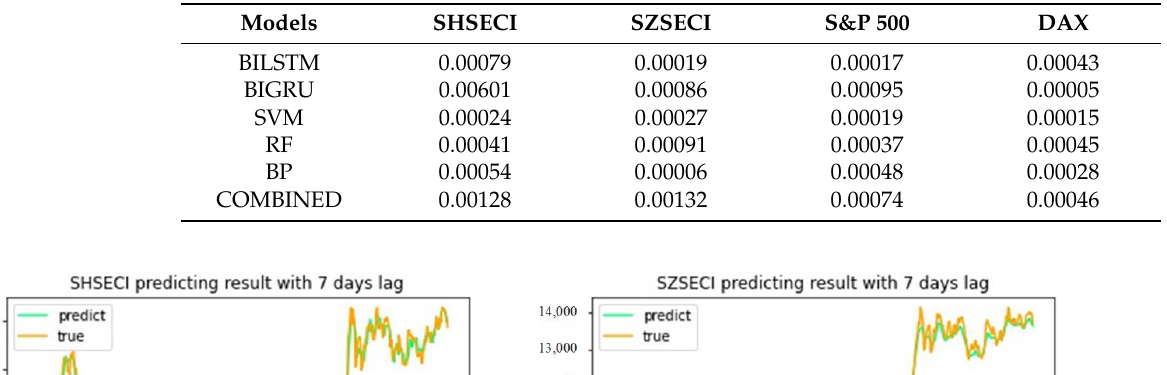
Table 6. Outcomes of z-tests between proposed and benchmark models in 7-day lag experiments.